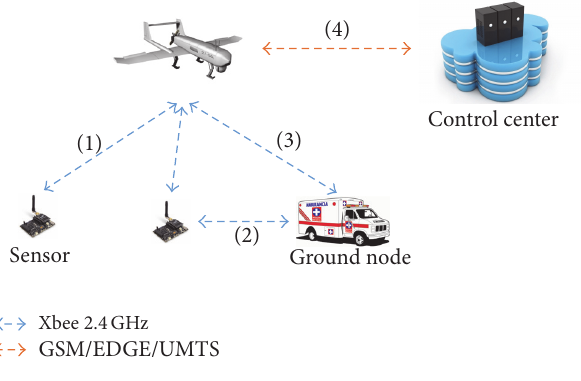
Figure 2: Network